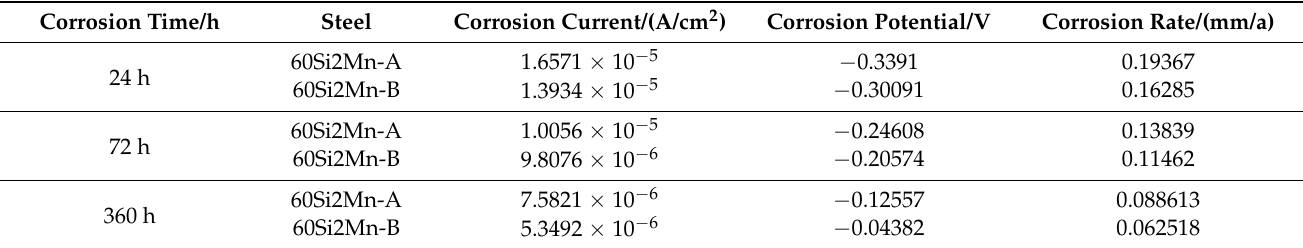
Table 3. Values of parameters fitted from polarization curves of